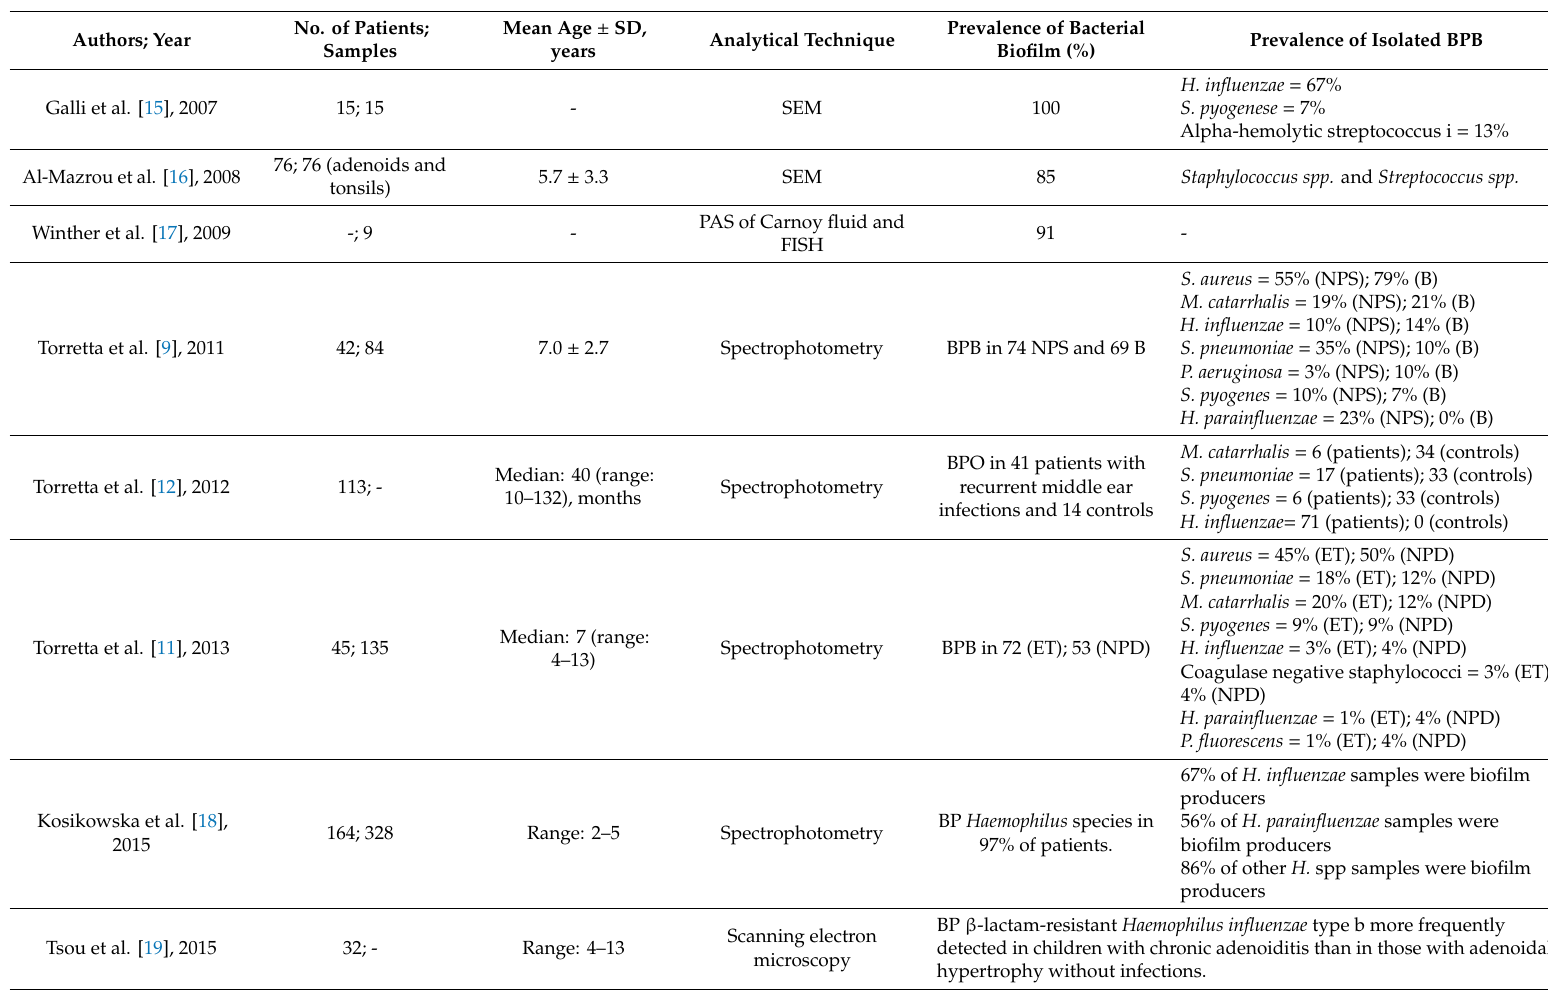
Table 1. Main characteristics and related microbiological findings of the main studies of bacterial biofilm in chronic